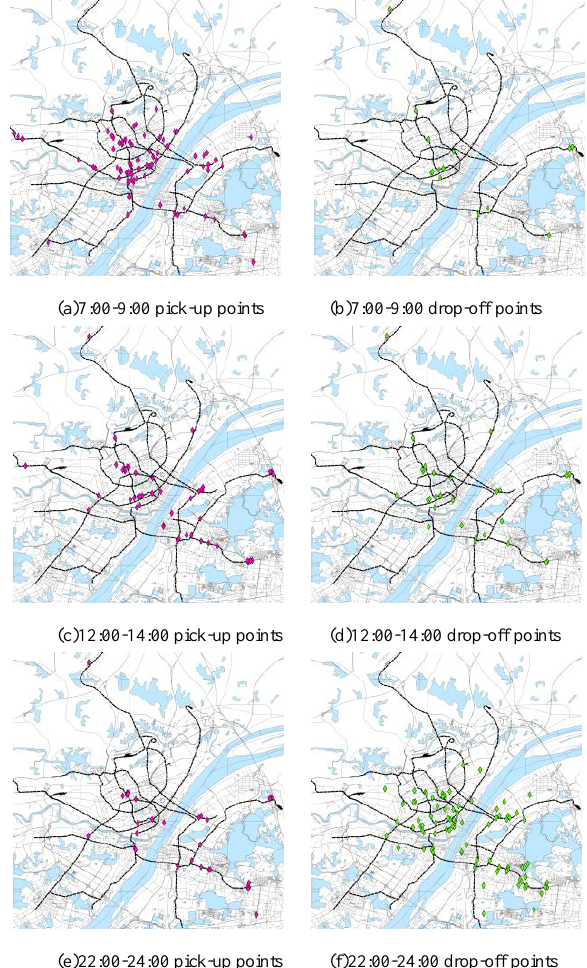
Figure 8. Distributions of level 4 and 5 docking points in different